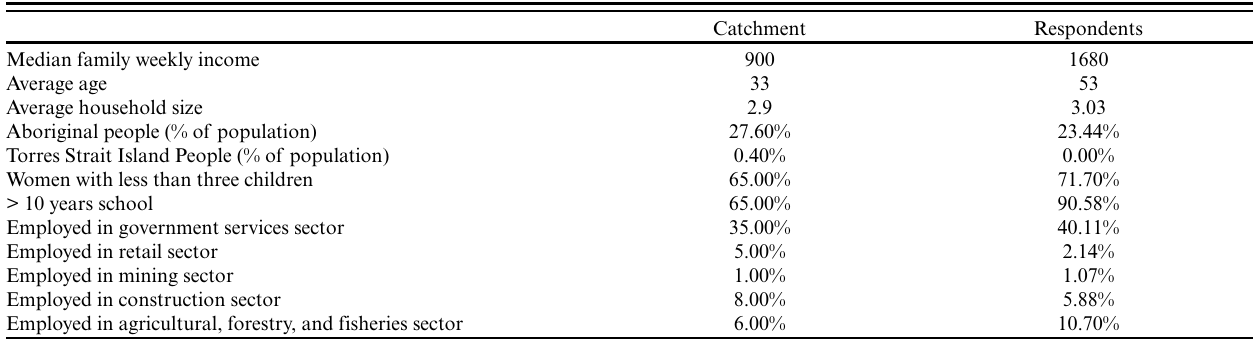
Table 3 . Characteristics of respondents and of residents in the Daly River catchment (catchment resident statistics derived from Australian Beareau of Statistics census data summarized at the catchment level, Larson and Alexandridis